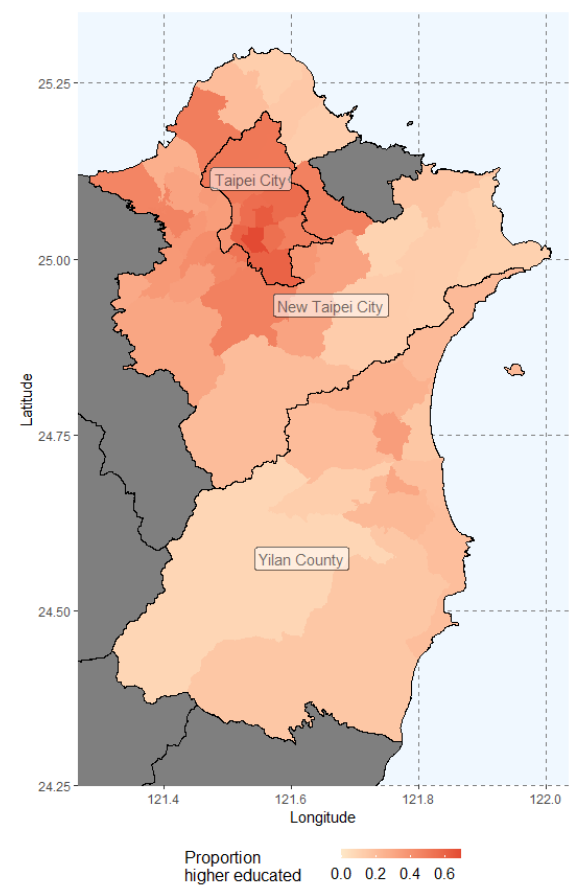
Figure 1. Proportion of higher-educated individuals in northern Taiwan, by township, city, and district. Notes: The map shows the proportions of individuals aged 15 years and over with junior college, university, or higher education in 2010. The spatial scale is town- ships/cities/districts, which are nested in Taipei City, New Taipei City (which roughly corresponds to Taipei County in our data, which was renamed New Taipei City in 2010), and Yilan County. Source of data: 2010 Population and Housing Census (DGBAS,